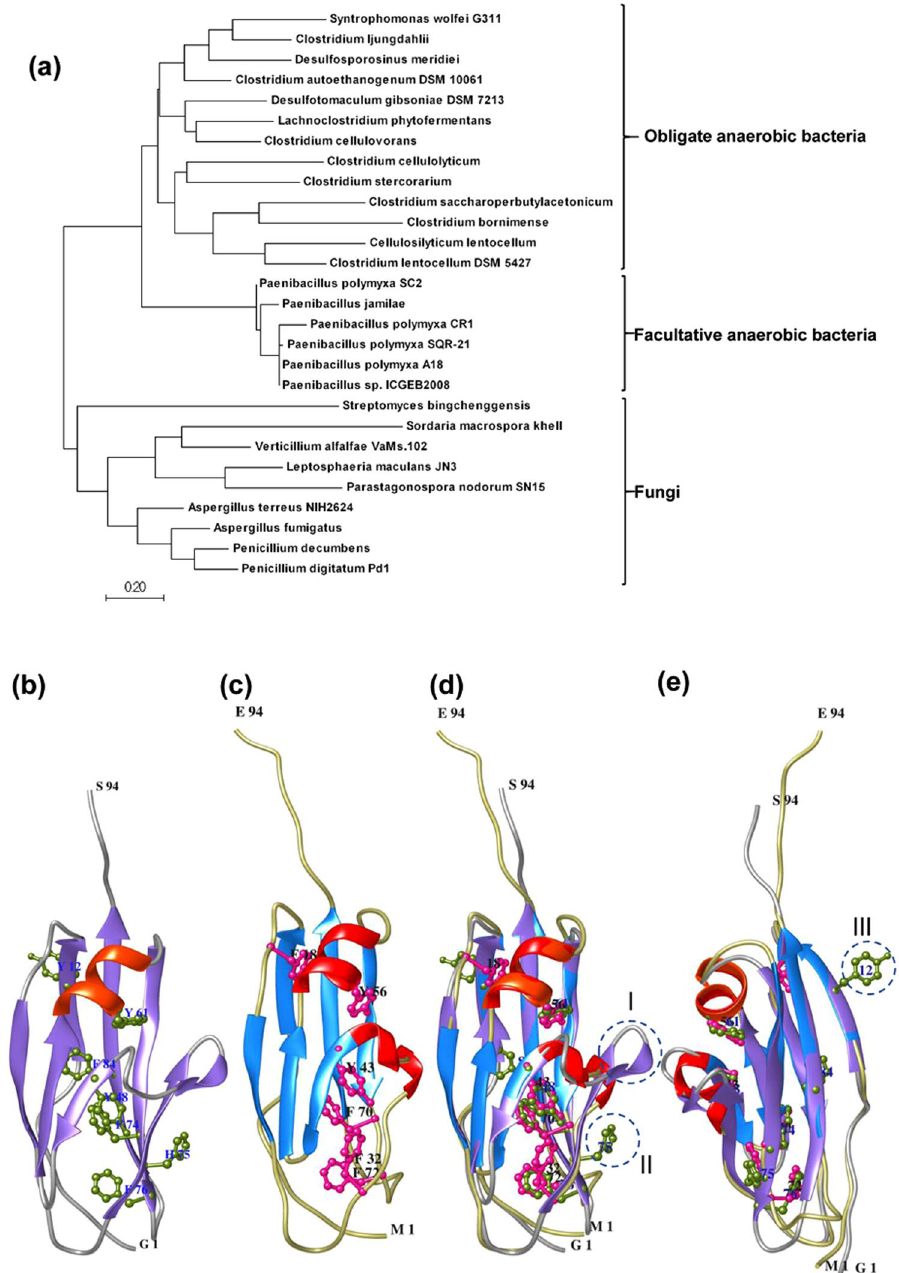
Figure 7. In silico analysis of module X2 of PP3 of P . polymyxa A18. ( a ) Molecular Phylogenetic analysis was performed by Maximum Likelihood method and the tree with the highest log likelihood is shown. Modelled structure of PP3-X2 ( b ), NMR-based structure of CipC-X2 ( c ) and superimposition of the two structures in two orientations ( d , e ) have been